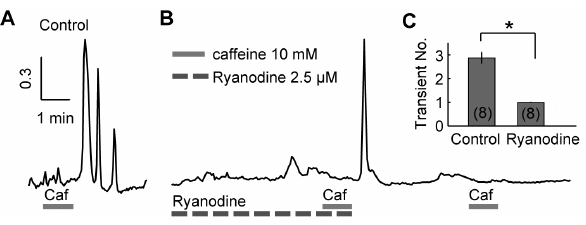
Figure 2. Ryanodine effect on the caffeine-induced [Ca 2 + ] i oscillations. A–B, Caffeine (10 mM, 60 s) induced [Ca 2 + ] i responses in: (A) normal Ringer’s solution (control), and (B) in the presence of ryanodine (2.5 m M). C, The average number of Ca 2 + transients induced by caffeine (10 mM, 60 s) in the control group and the ryanodine group. * denotes statistical significance of p , 0.05 with independent- samples t